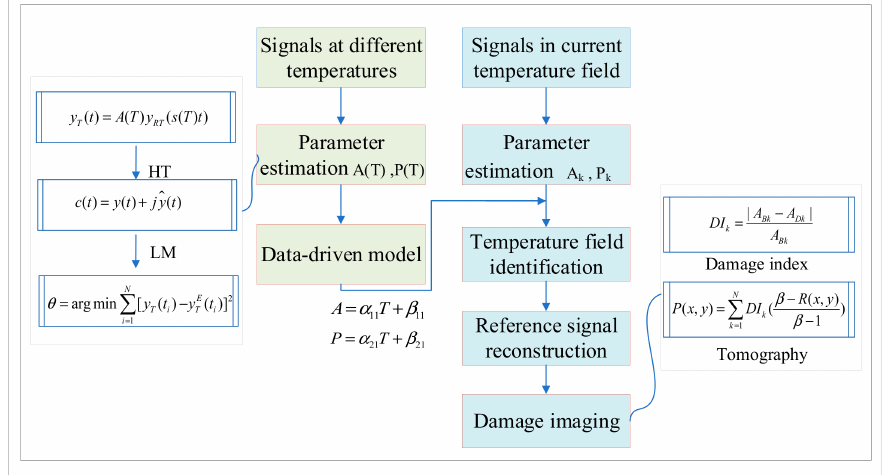
Figure 2. Process of temperature compensation for damage detection.